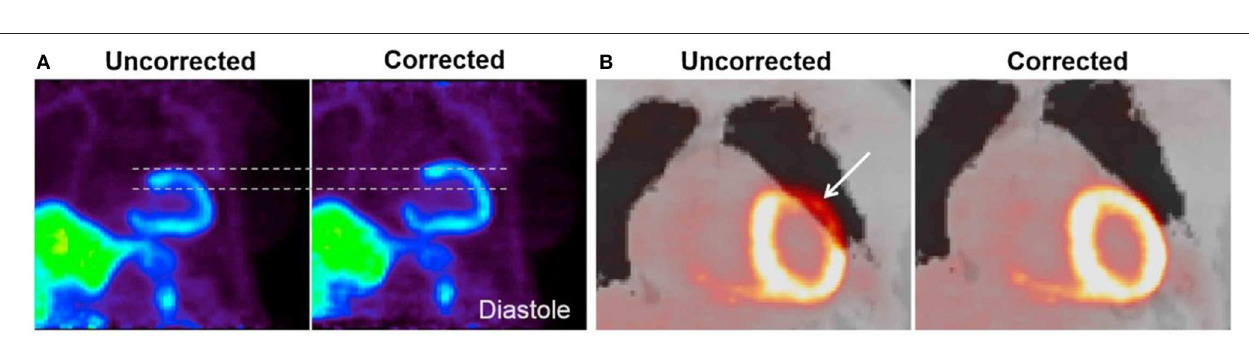
FIGURE 5 | Effect of respiratory and cardiac motion on PET image quality. (A) Blurring effect due to cardiac motion in a patient scanned with 13N-NH3. (B) Misalignment artifact between the PET-emission data and the corresponding MR-AC map. Misalignment artifacts like these are common in cardiac PET-imaging, where they are known to cause false-positive findings in up to 40% of all studies [180]. Reprinted from Rausch et al. [181] with permission from